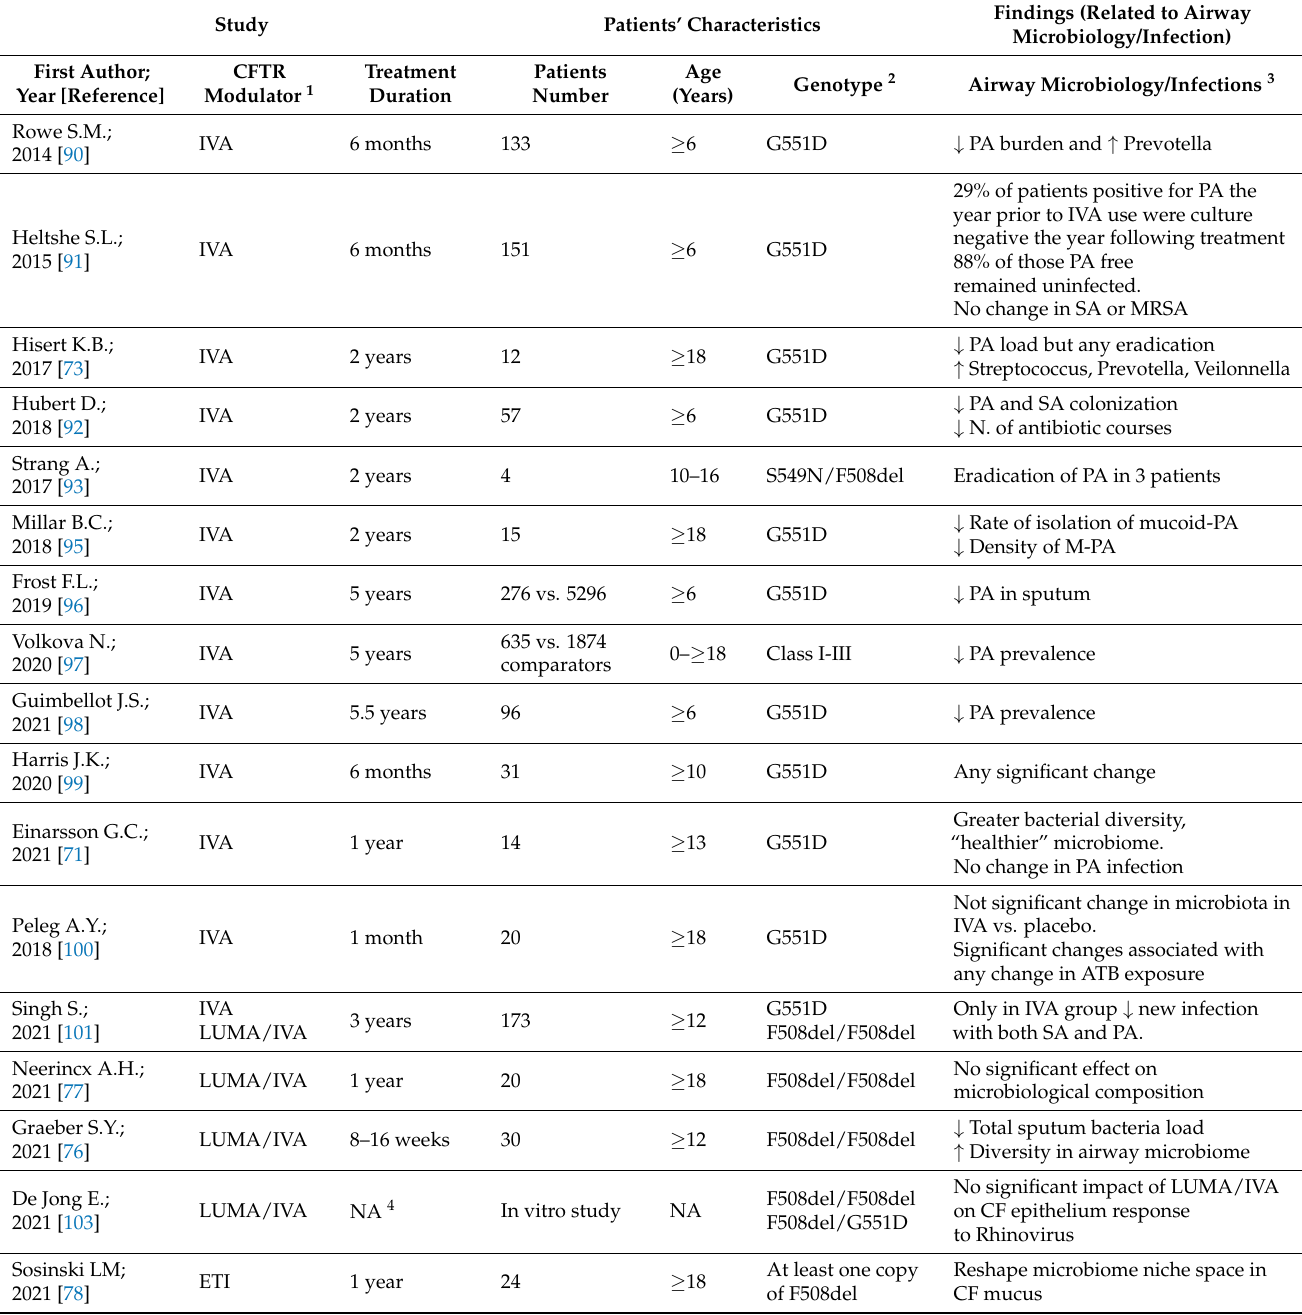
Table 2. Effects of CFTR modulators on airway